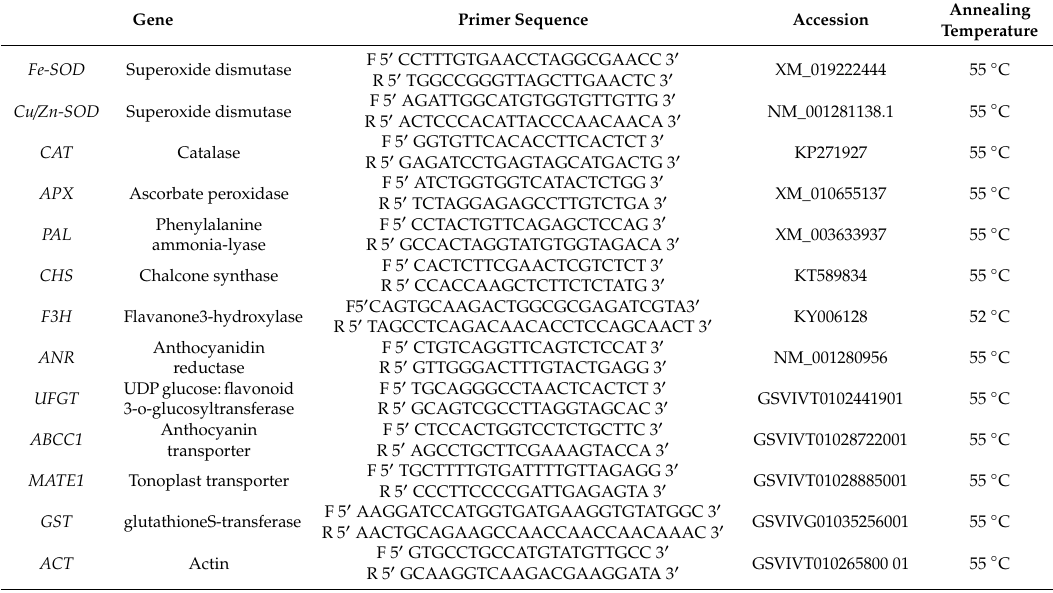
Table1. Annealingtemperature,